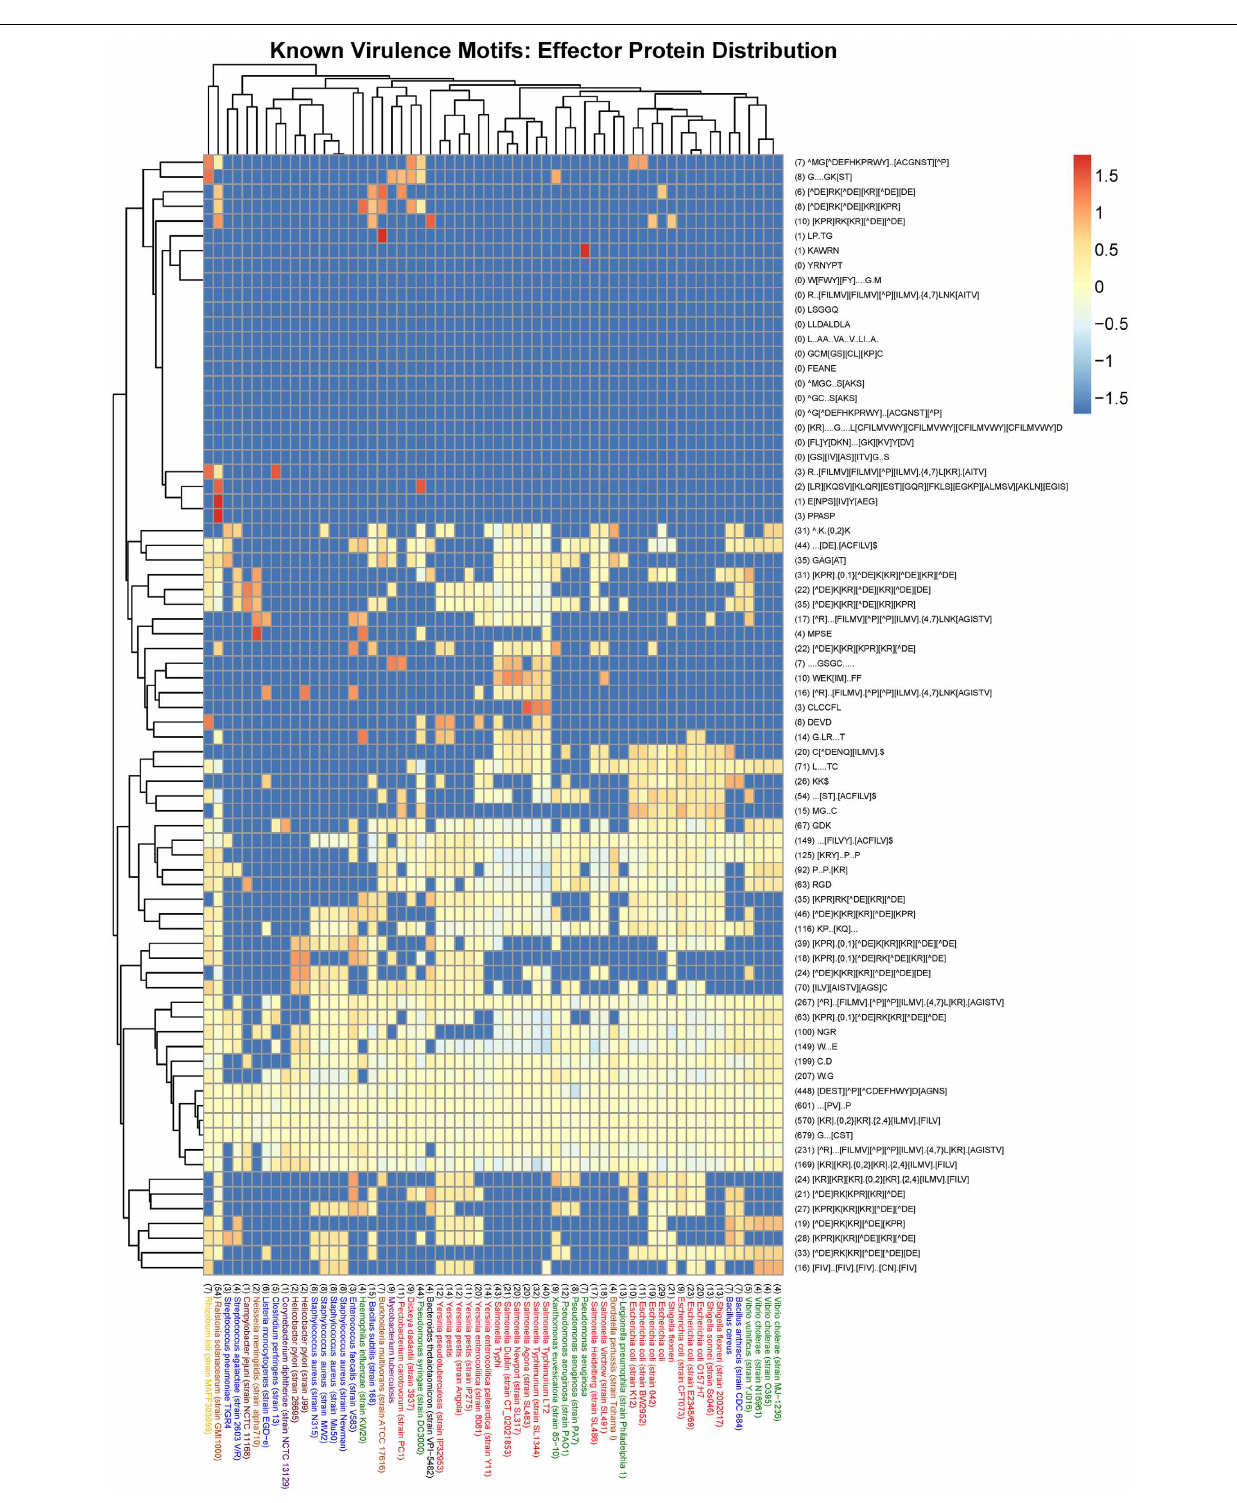
e-proteobacteria; Green, g-proteobacteria (non-enterobacteria); Red, g-proteobacteria (enterobacteria); Black, others (CFB). Rows: The motif regular expression with the total number of incidences in UPCs across all 60 organisms indicated in brackets at the start of the description. Color scale: The logarithm of the normalized N_UPC returned from the SLiMSearch results.